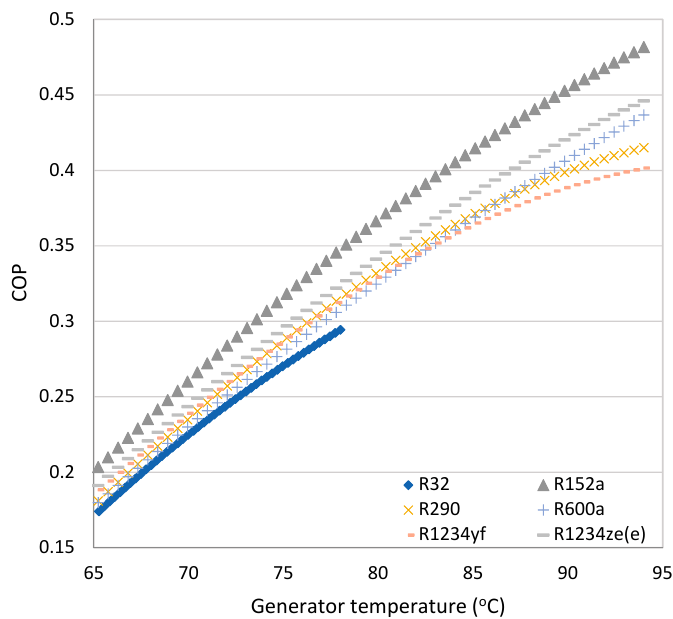
Figure 7. System performance as a function of generator temperature ( T e = 10 ◦ C and T c = 30 ◦ C )